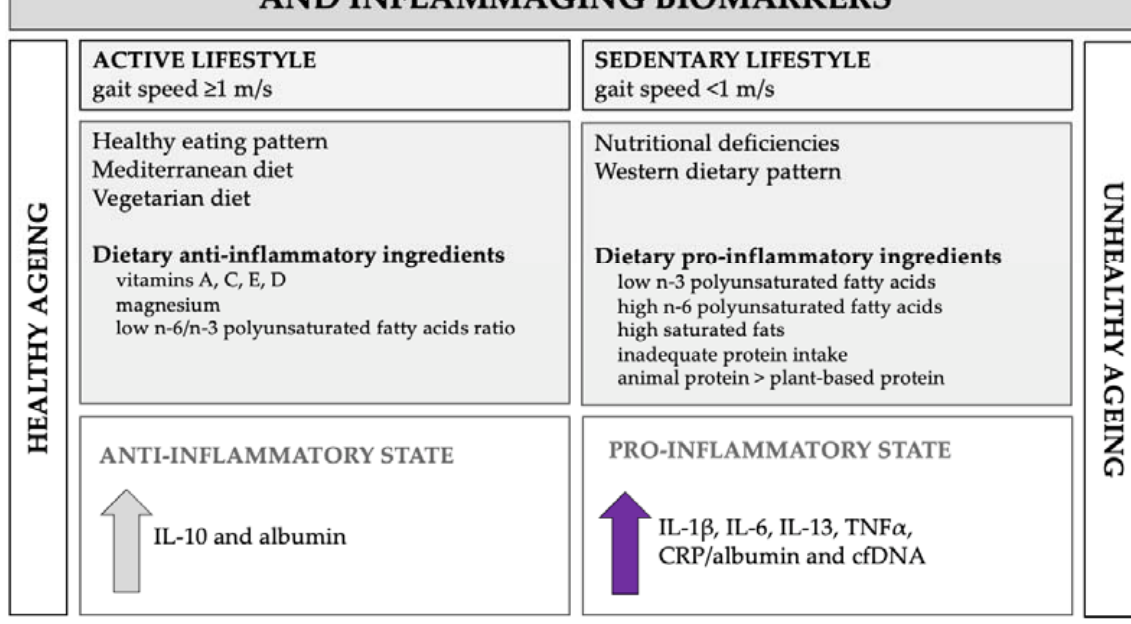
Figure 5. Association between dietary intake, physical activity and biomarkers of the ageing immune system.